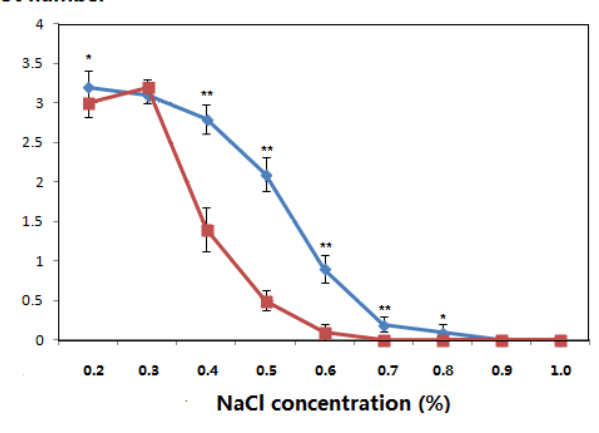
Figure 7. Rooting at various NaCl concentrations (0.2%–1%) after 35 days. A one-way ANOVA was used to discriminate between the number of roots in the two groups in the presence of different concentrations of NaCl (%). The transgenic explants (blue line) showed greater rooting ability in the presence of a high NaCl concentration than did the wild-type plants (red line) (* 0.01 < p < 0.05; ** p < 0.01, α = 0.05).